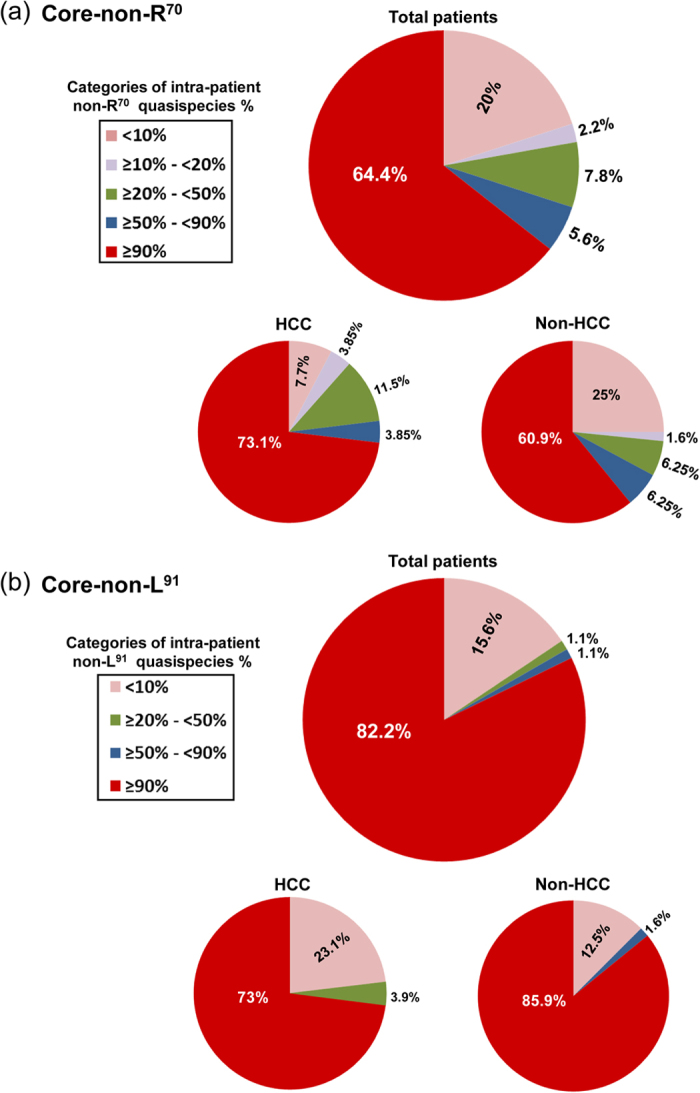
Frequency of intra-patient non-R70 and non-L91 quasispecies at various percentage cut-points in baseline samples among total patients (n = 90), those who later developed HCC (n = 26) and those who did not (non-HCC) (n = 64).The non-R70 (a) and non-L91 (b) intra-patient quasispecies cut-point percentages are categorized and indicated in the box legends.